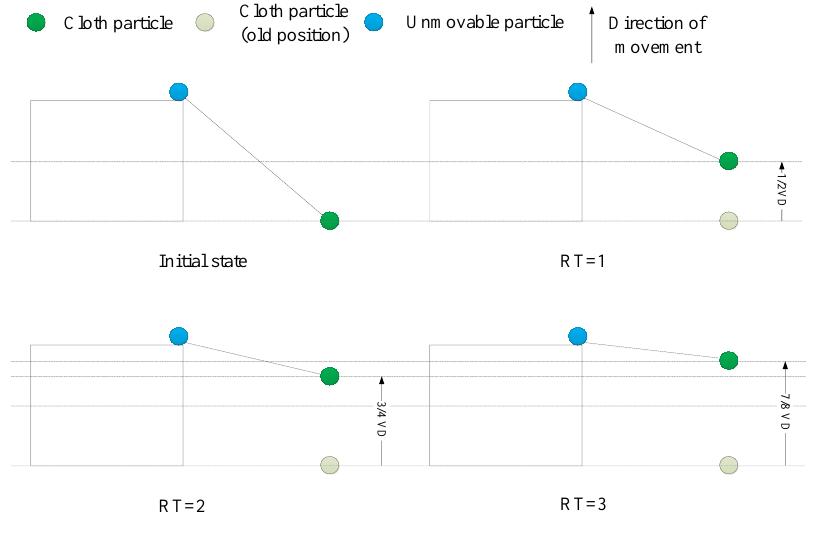
Figure 5. Parameterization of rigidness.